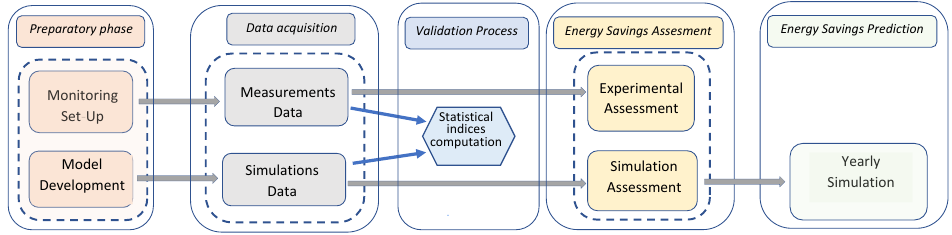
Figure 1. Flow chart of the used